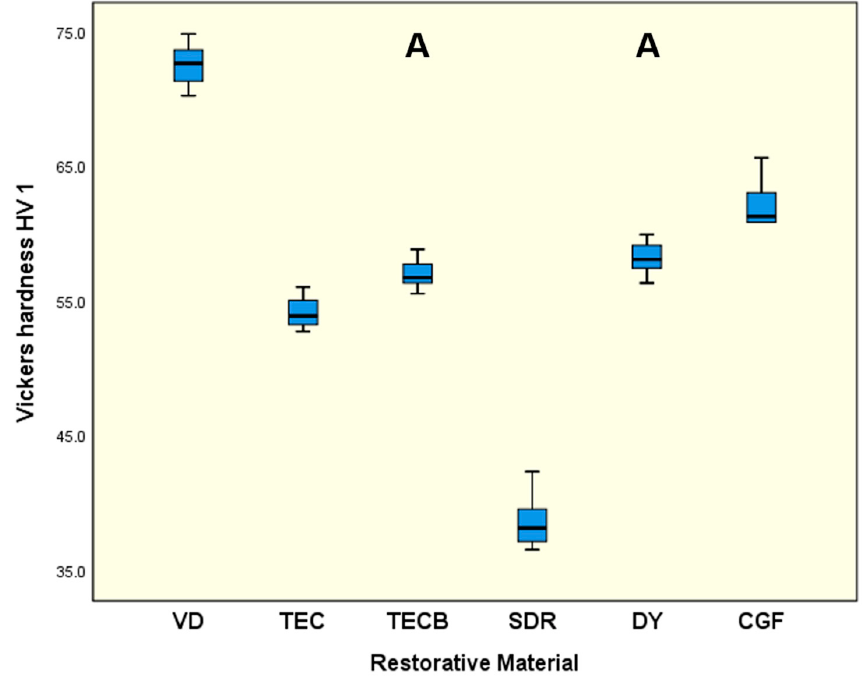
Figure 8. Vickers hardness (HV 1). Identical uppercase letters denote no significant difference among groups ( p > 0.05).